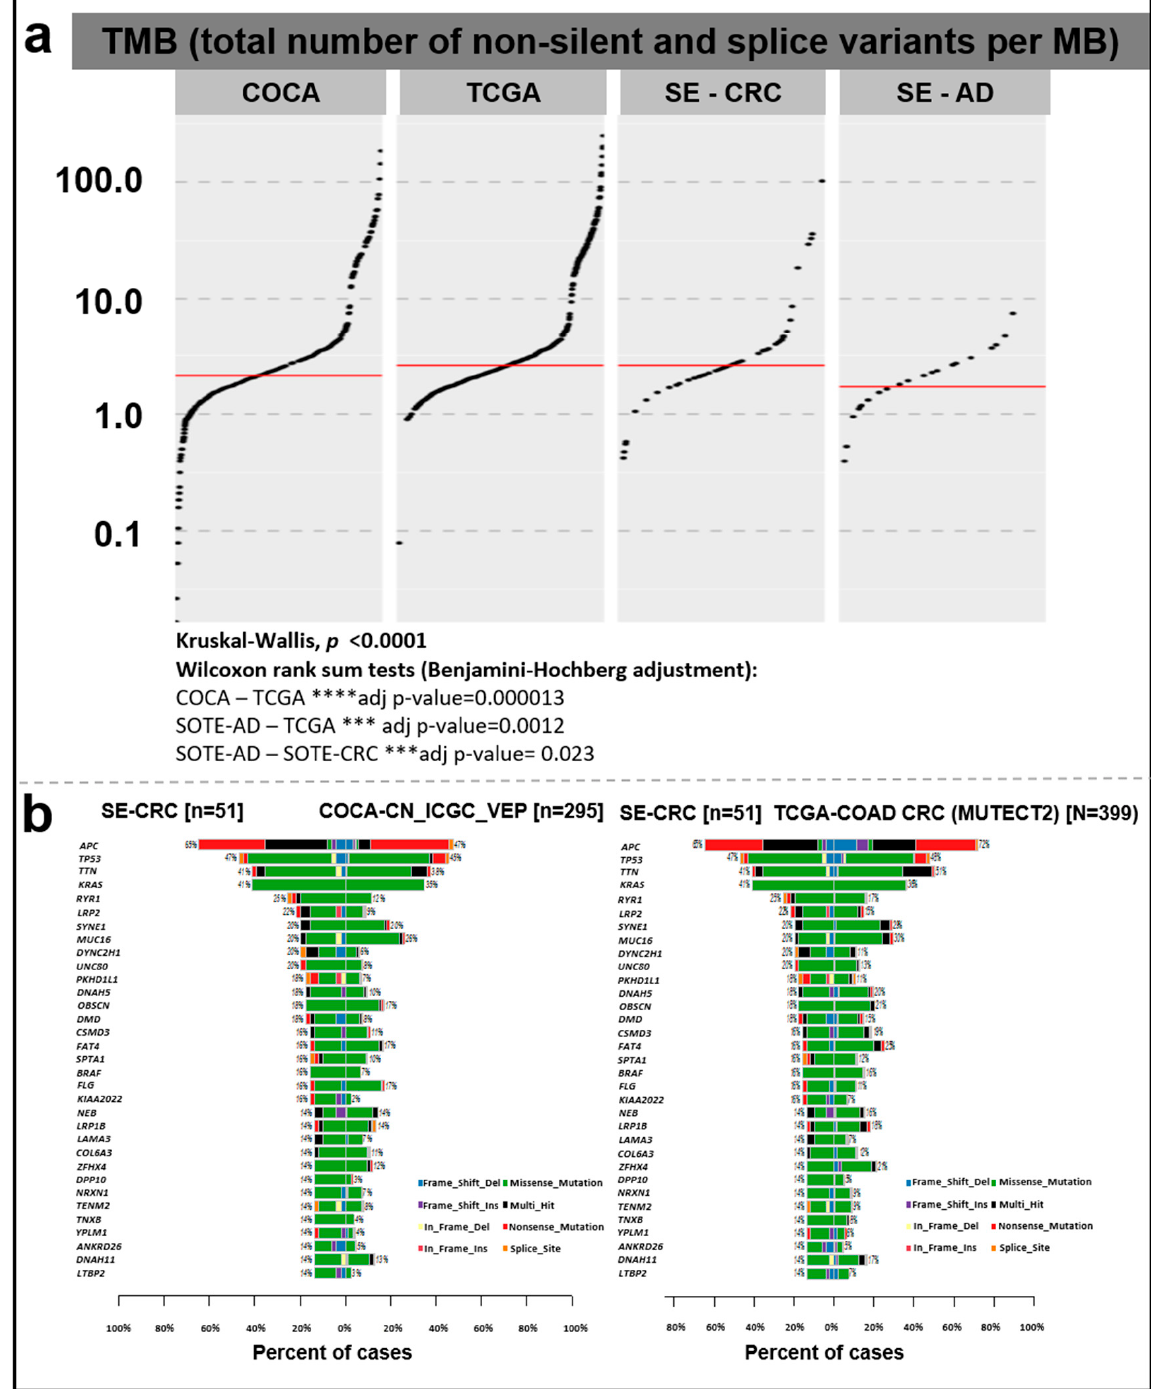
Figure 3. ( a ) Tumor mutation burden in AD and CRC samples of our cohort (SE-AD, SE-CRC) compared to the COCA and TCGA COAD + READ reference datasets. The total numbers of non-silent and splice site variants were divided by 38 Mb and were represented on a log10 Y-scale. The red lines show median values. ( b ) Direct pairwise comparison of mutation frequencies of genes in our cohort compared to COCA (left) and TCGA COAD + READ (right) datasets showing the percent of affected samples (%). Table 2. Fisher’s exact test results of the comparison of CRCs from our cohort with COCA and TCGA ( p < 0.01).